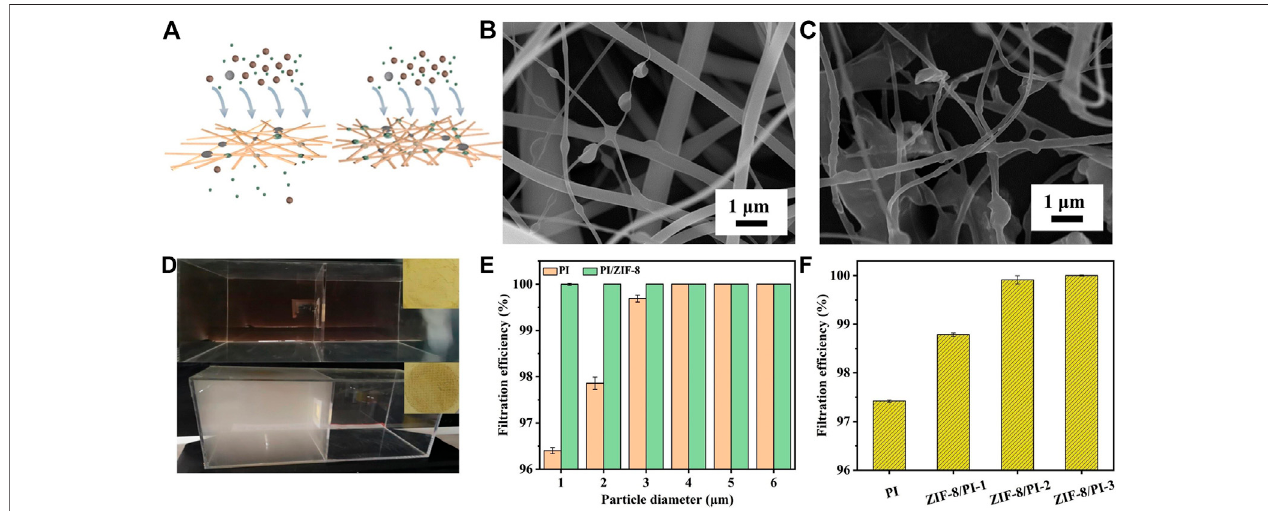
FIGURE 3 | (A) Diagram of different fi ber membranes before and after fi ltration. (B) Scanning electron micrograph (SEM) of the PI fi ber membranes after fi ltration. (C) SEMoftheZIF-8-3/PI fi bermembranesafter fi ltration. (D) Digitalimageofthenano fi ber fi ltermembranebeforeandafter fi lteringinthe fi lteringdevice. (E) Comparison ofthe fi ltrationef fi ciencyofthePIandZIF-8/PI-3 fi bermembranesforPM 0.3 fi ltrationattheair fl owrateof6 L/min). (F) EffectsofthePInano fi bermembraneswithdifferent ZIF-8 loadings on PM 0.3 fi ltration ef fi ciency.